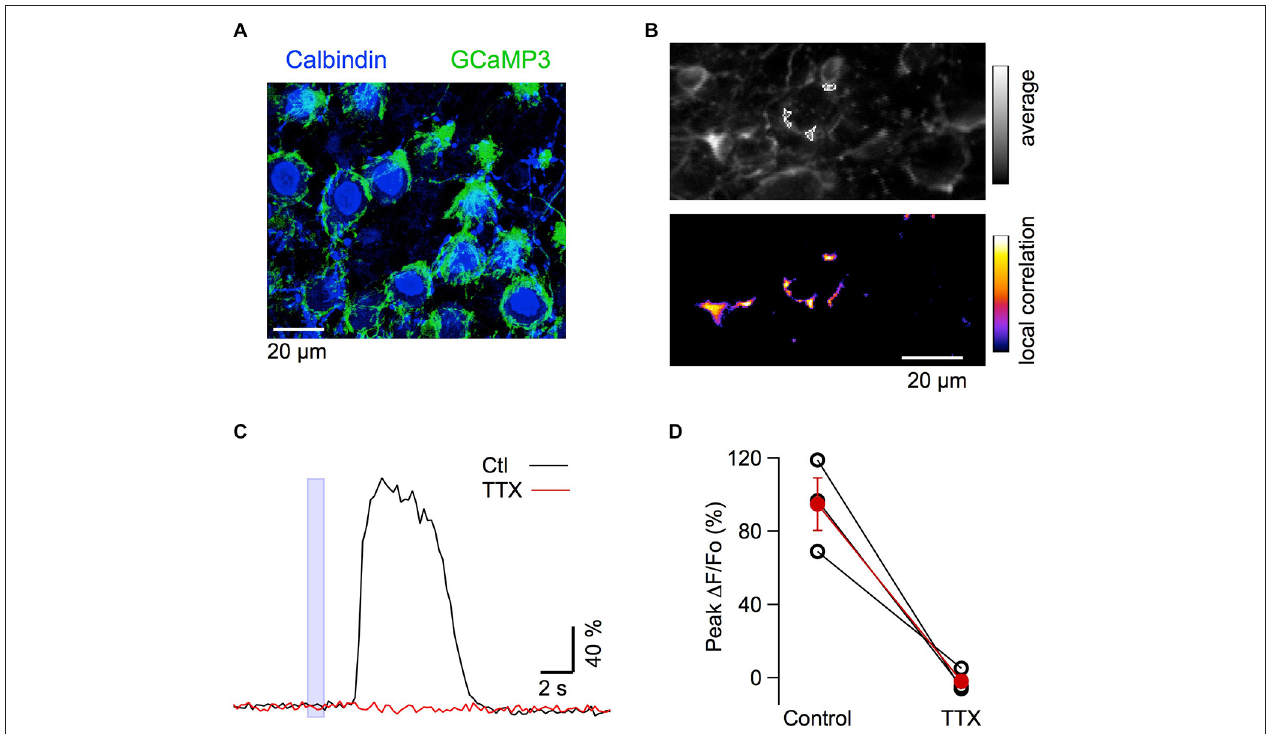
drawn over the average image in (B) . (C) Time course of the response to muscimol in control period and 24–34 min after addition of TTX to the solution bathing the craniotomy. Responses were averaged from all ROIs and over 3 consecutive trials in each condition. (D) Block by TTX of the fluorescent responses in basket varicosities. Pair plots for the peak ∆ F/Fo values in control condition and in the presence of 2 µ M TTX for three different animals; the red dots give mean ±